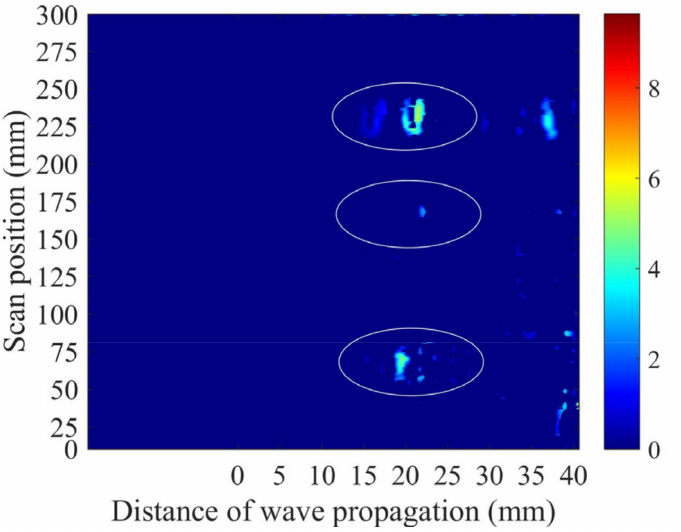
Figure 11. B-image for the weld specimen obtained using the A-wave signals and optimized using the time-dependent threshold. The real flaws and their positions are marked in the